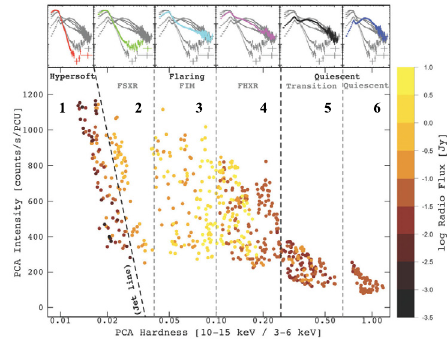
Figure 8. Diagram of states adopted from [20] crease) corresponds to region 5 in Fig. 8. The increase in the intensity of emission with a hard spectrum observed in 2006 (Fig.5) corresponds to region 2 on the diagram. The quiescent state at very high energies (Fig. 7) refers to re- gion 6 in Fig. 8. As a result, the diagram of states from [20] can be supplemented with information about the be- havior of Cyg X-3 at very high energies, namely with the data on the intensity and spectral characteristics in the ob- servation intervals under